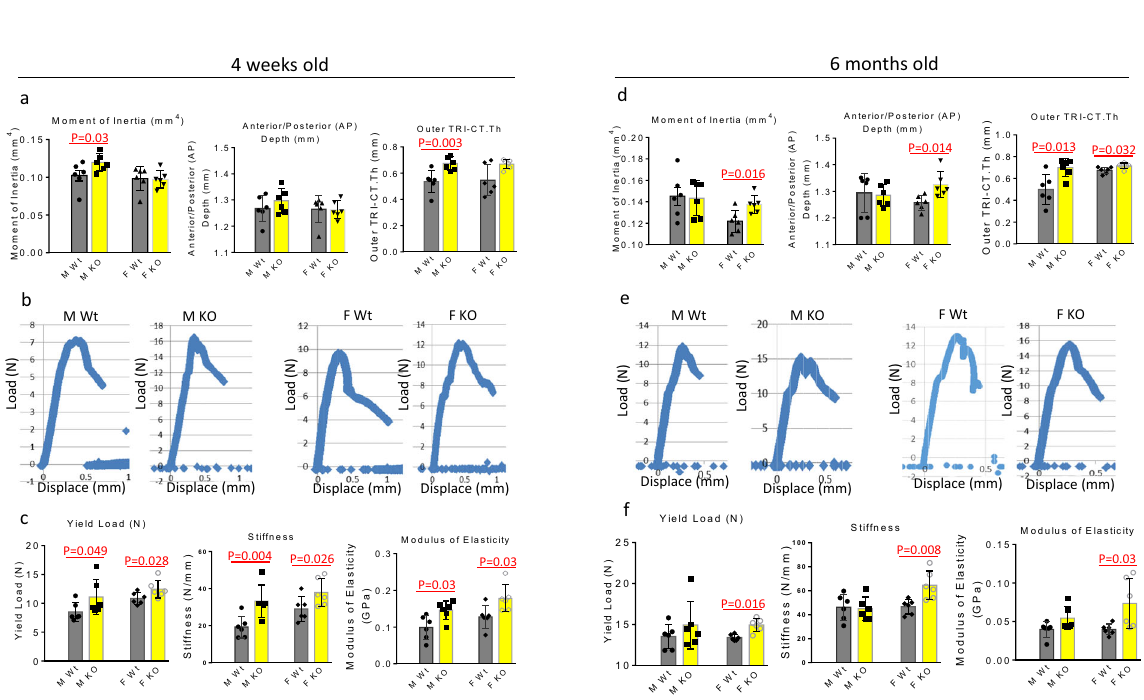
Fig. 3 Biomechanical testing of mouse femurs using three-point bending. a Three different Micro-CT parameters of femurs from 4 weeks old and, d 6 months old mouse before three-point bending tests. b Represented association curves between inverse load ( y axis) and inverse displace ( X axis) from three-point bending tests of femurs from 4 weeks old and, e 6 months old mice. c Bone strength parameters after three-point bending tests of 4 weeks old and, f 6 months old mouse femurs. Male wild type (M Wt), male GPR109A − / − (M KO), female wild type (F Wt), female GPR109A − / − (F KO) mice. Red p = numbers mean signi fi cantly different versus respective wild type mice by t -test, n = 6, mean ± compared to their wild type controls (Table 2), indicating bone representative pQCT images in Fig. 4a (three images per group are quality is better in GPR109A − / − mice. Right tibia was cryosec- shown), color changes from black to white indicate changes in trabecular bone density from lower to higher; clearly, bone density tioned for bone histological study. TRAPase staining was performed in GPR109A − / − mice was higher than control wild type mice. In on cryosectioned tibia (three samples per group are presented in Fig. 4b), and pink stained TRAPase-positive osteoclastic cells in accordance with color changes on pQCT images, pQCT parameters samples from GPR109A − / − mice were clearly fewer than samples of trabecular density increased about 25% in GPR109A − / − mice compared to their wild type controls (Table 2), body weight and from wild type controls (Fig. 4b). Osteoclast numbers were sig- tibia length were not signi fi cantly different. While total BMD sig- ni fi cantly decreased (Fig. 4c), while osteoblast numbers (Fig. 4d) ni fi cantly increased in GPR109A − / − mice, cortical BMD did not were signi fi cantly increased in GPR109A − / − mice compared with show signi fi cant changes in this age of GPR109A − / − mice com- their wild type controls. In accordance with this, bone marrow plasma osteoclastic resorption marker CTX-1 showed signi fi cantly pared with their control wild type mice (Table 2). SSI polar, a lower levels in mice from GPR109A − / − compared with their wild calculated parameter of pQCT analysis re fl ecting bone bending type controls (Fig. 4e), on the other hand, serum bone formation strength, was signi fi cantly increased in GPR109A − / − mice